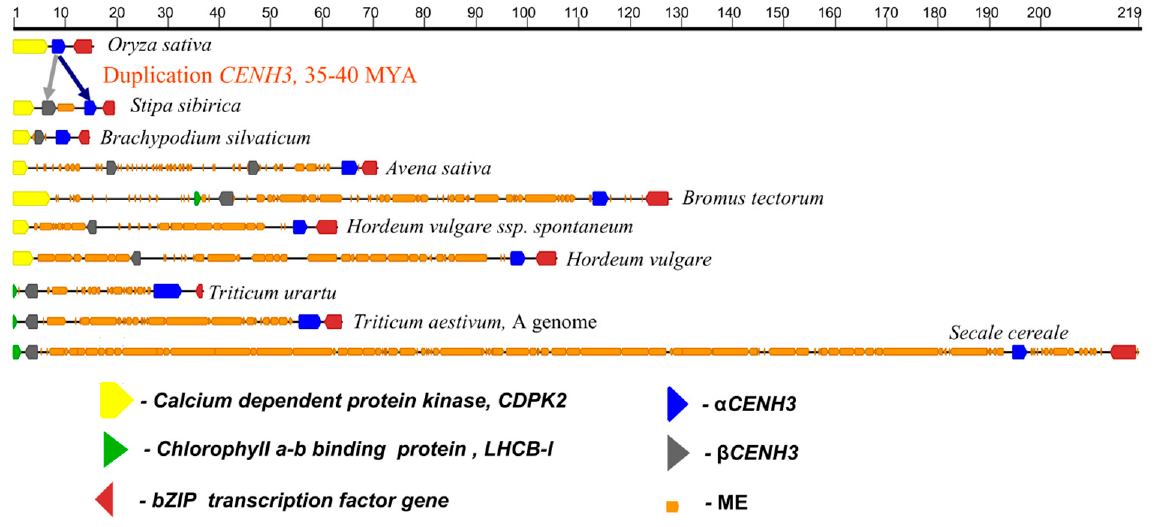
Figure 4. Evolution of the CENH3 locus from its emergence in the ancestor of rye ( O. sativa ) to the domesticated species in the tribe Triticeae. The numbers at the top show distances in kilobases. The genes are calcium dependent protein kinase, CDPK2 (yellow finger-post arrows); chlorophyll a-b binding protein, LHCB-l (green finger-post arrows); bZIP transcription factor gene (red finger-post arrows); α CENH3 (blue finger-post arrows); β CENH3 (gray finger-post arrows) and transposable elements (brown rectangles). Table 1. Size of the CENH3 locus and its structural elements (genes and intergene spacers, ISs) in various cereal genomes *.